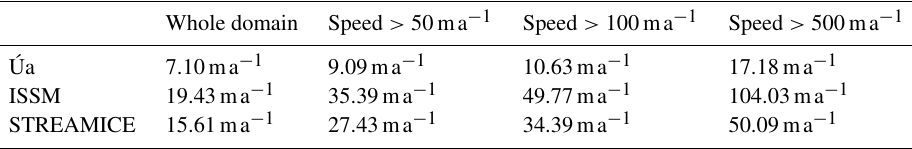
Figure 3. Difference in the calculated speeds after inversion, compared to the measurements, for each model. The grounding line is indicated in black. Table 1. Mean values for the magnitude of misfit in inversions from the three models on regions with ice over chosen measured speed